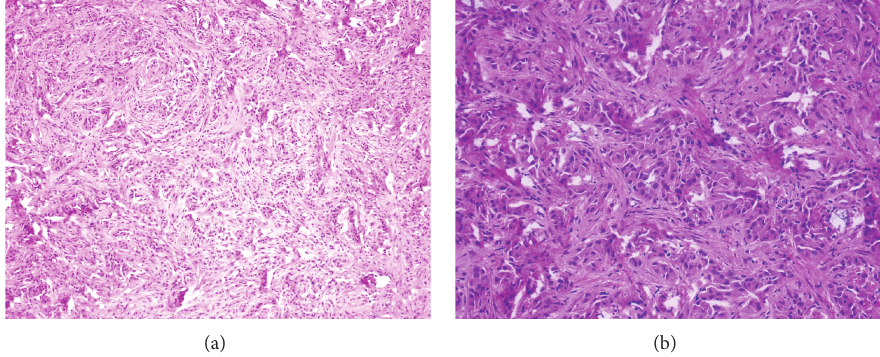
Figure2:HEstainingofAT:(a)hematoxylin-eosinstainoftumorbiopsyshowingtumorcellslinedinirregular,glandularpattern,andfibrous tissue proliferation in stroma with unclear margins ( × 100); (b) the neoplastic cells had round to polygonal outlines, moderate to abundant pale to vacuolated cytoplasm with round or oval nuclei. No mitoses were seen (hematoxylin-eosin, × 200).